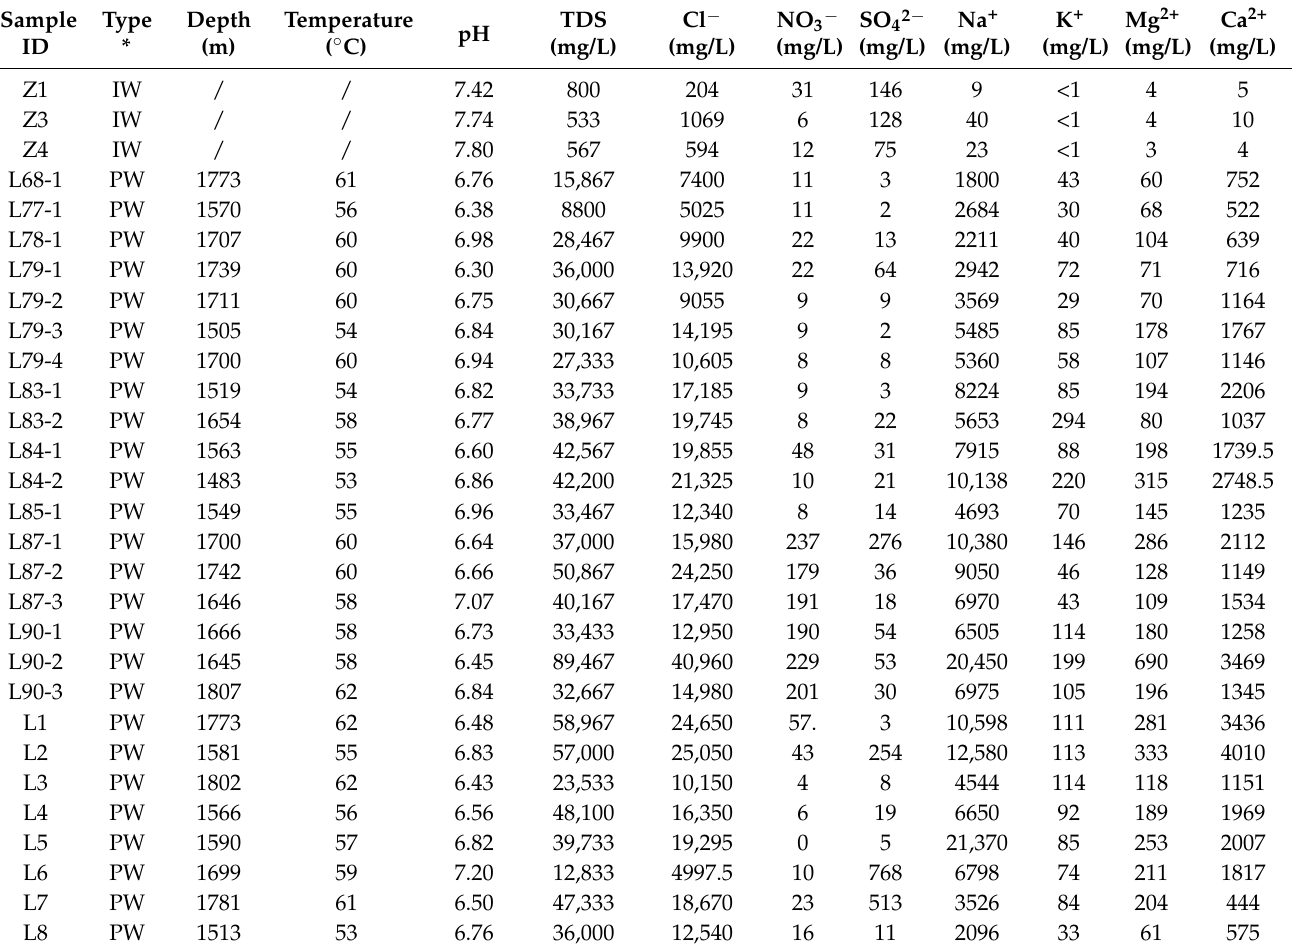
Table 1. Physicochemical parameters of the